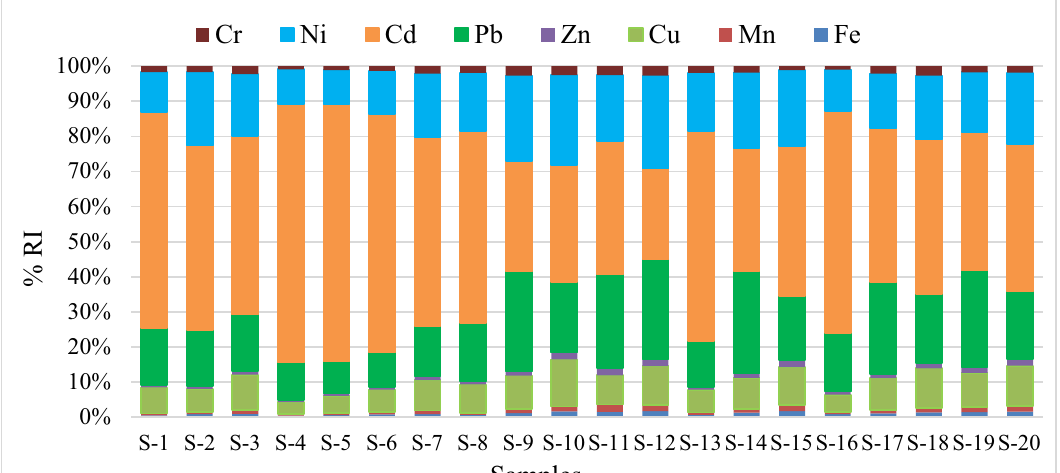
Figure 9. Contribution of individual trace metals to RI in the Sundarbans